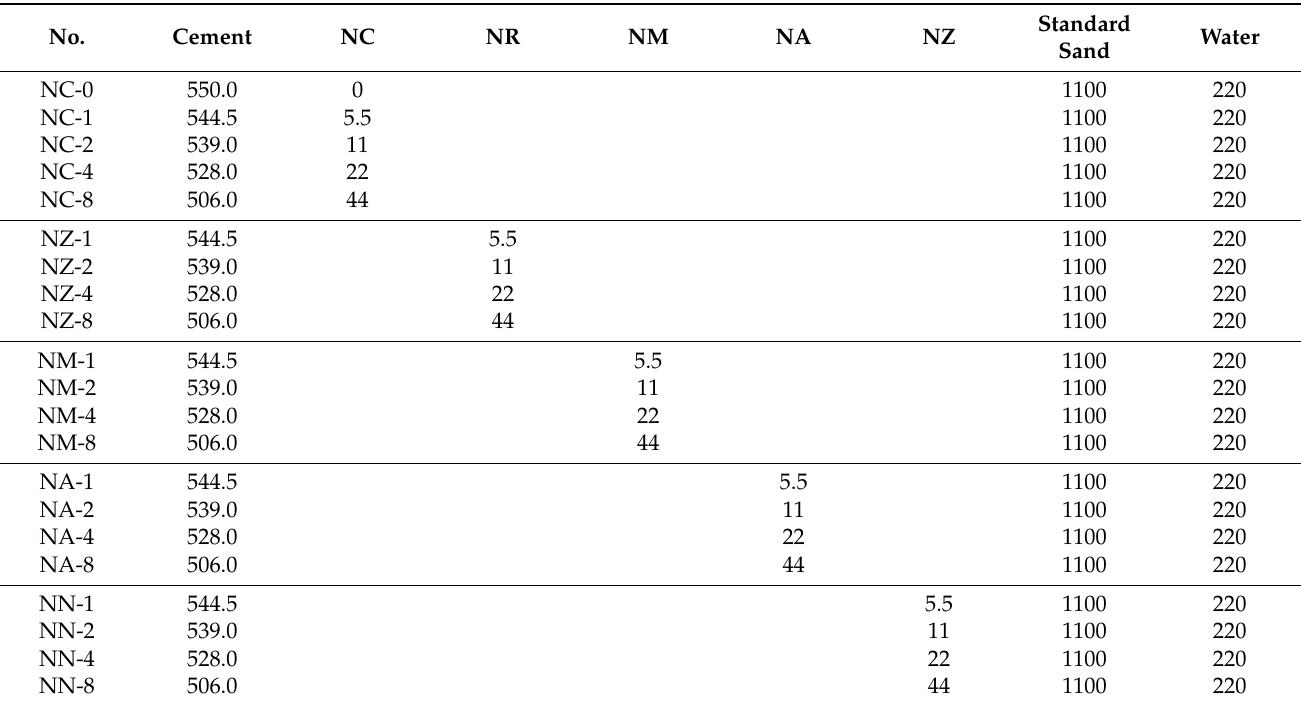
Table 4. Mixture